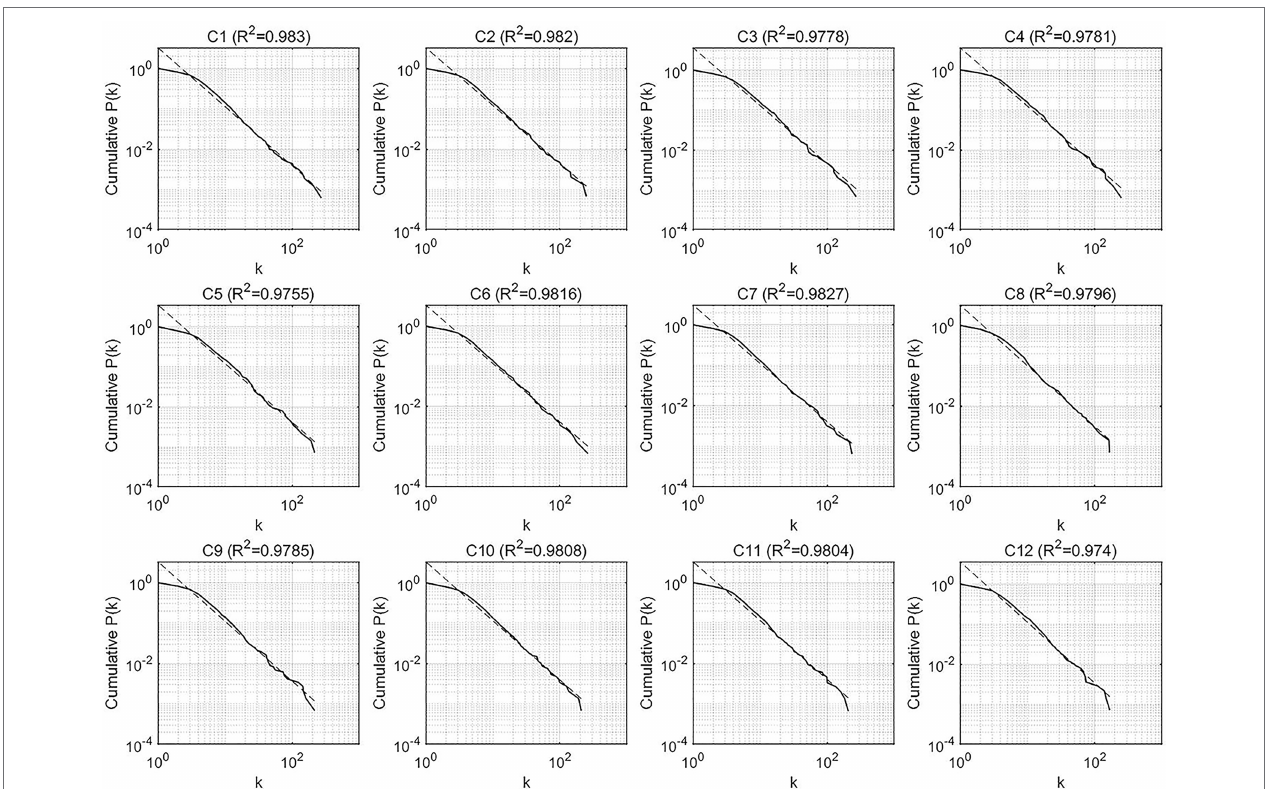
FIGURE 5 | The cumulative degree distributions of the syntactic dependency networks of SI